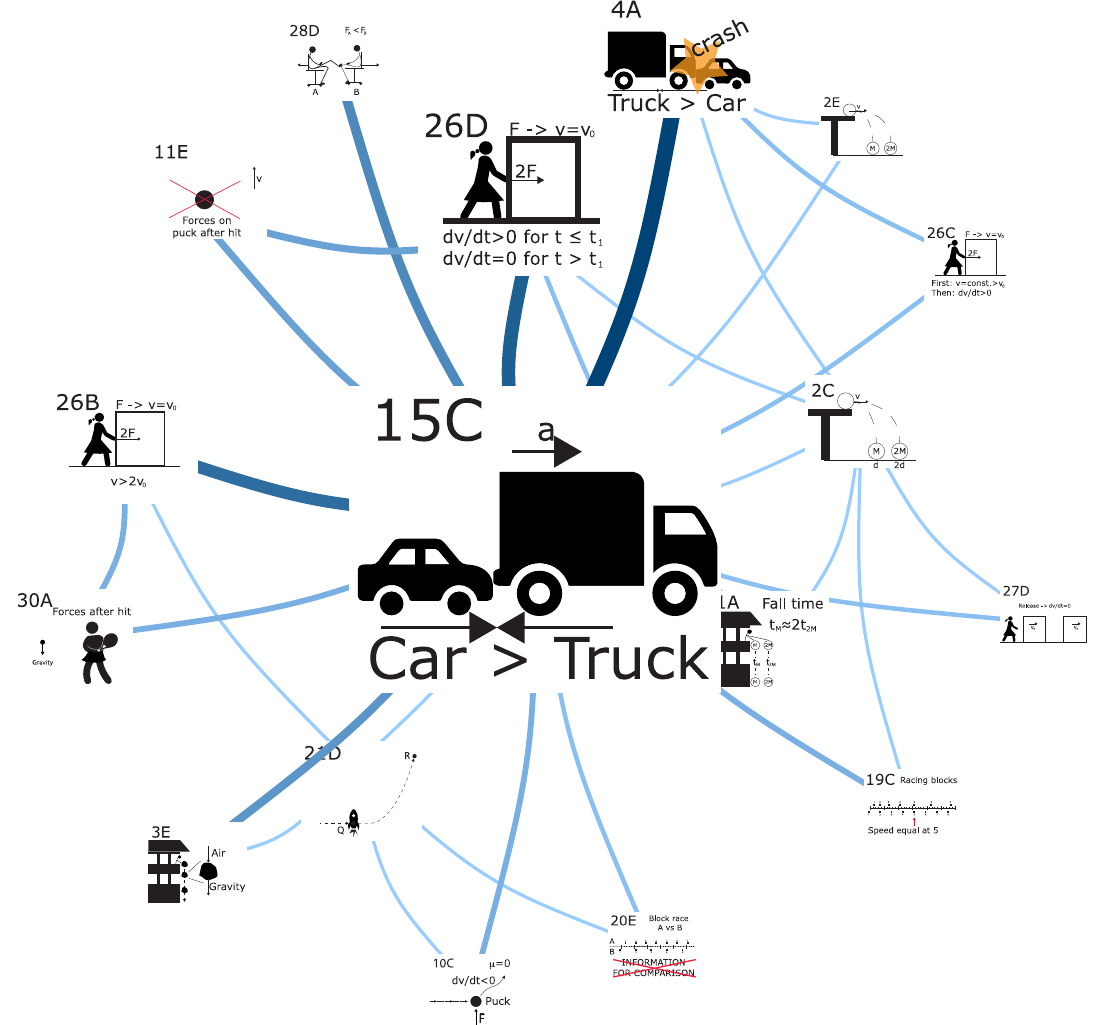
FIG. 10. Illustration of the more force yields more results module using pictograms. Each pictogram represents a response